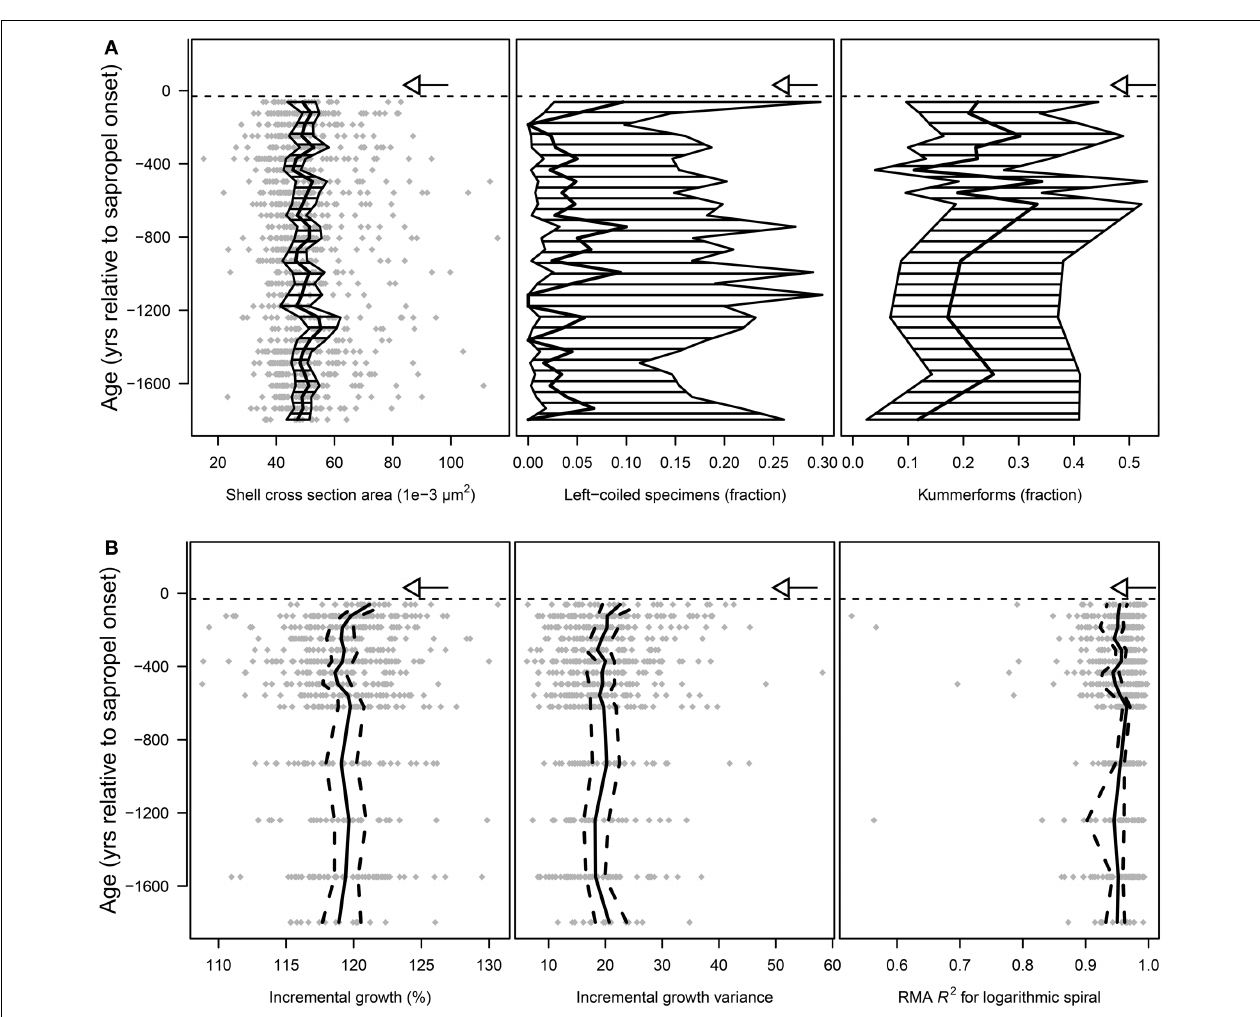
FIGURE 6 | Morphological analyses of shells of Globorotalia scitula from core M51-3/SL104. Kummerforms are specimens in which the last chamber is smaller than the penultimate chamber. The horizontal dashed lines mark the onset Sapropel S5, the arrows mark the local extinction of the species. (A) Arithmetic mean values (thick black line) and 95% confidence intervals of the mean (hatched area), and in the case of shell size the raw values as gray